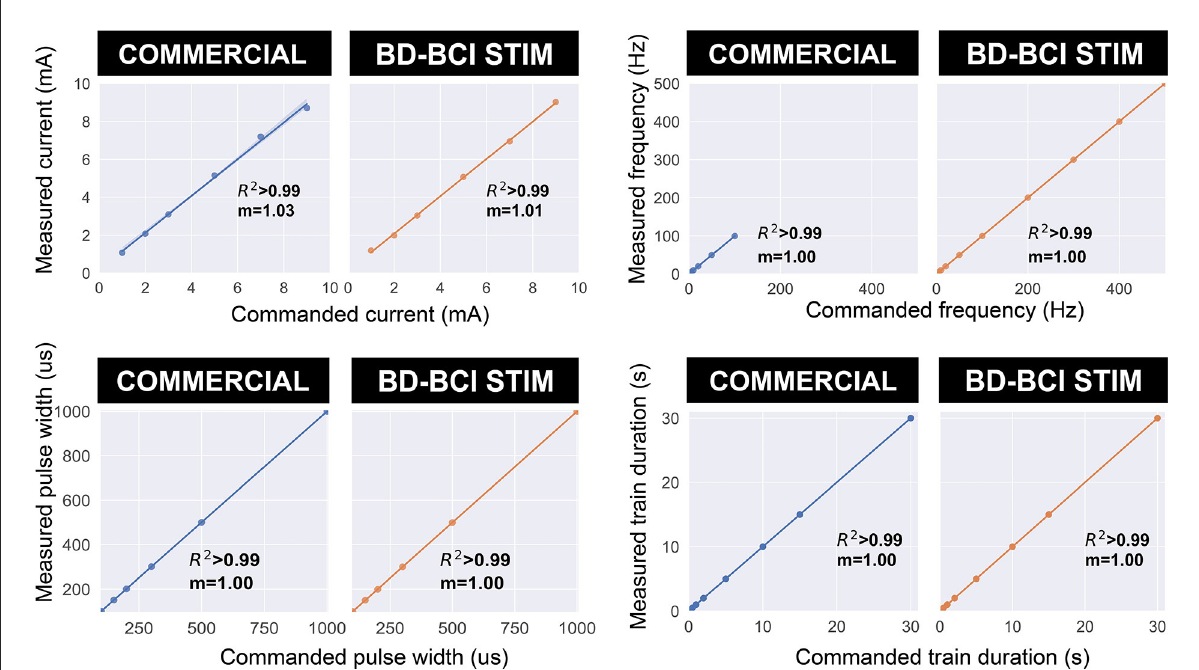
FIGURE7 The accuracy of the commercial and BD-BCI stimulator. The comparison plots summarize the output equivalence of the BD-BCI stimulator to the FDA approved commercial stimulator. The measured controllability, outputs in the current amplitude, pulse width, pulse frequency, train duration are demonstrably equivalent. The labeled coefficient of determination (R 2 ) indicates that the outputs are accurately controlled in all output categories. Specifically, the results indicate that both the commercial and BD-BCI stimulator deliver stimulation at exact parameters which were